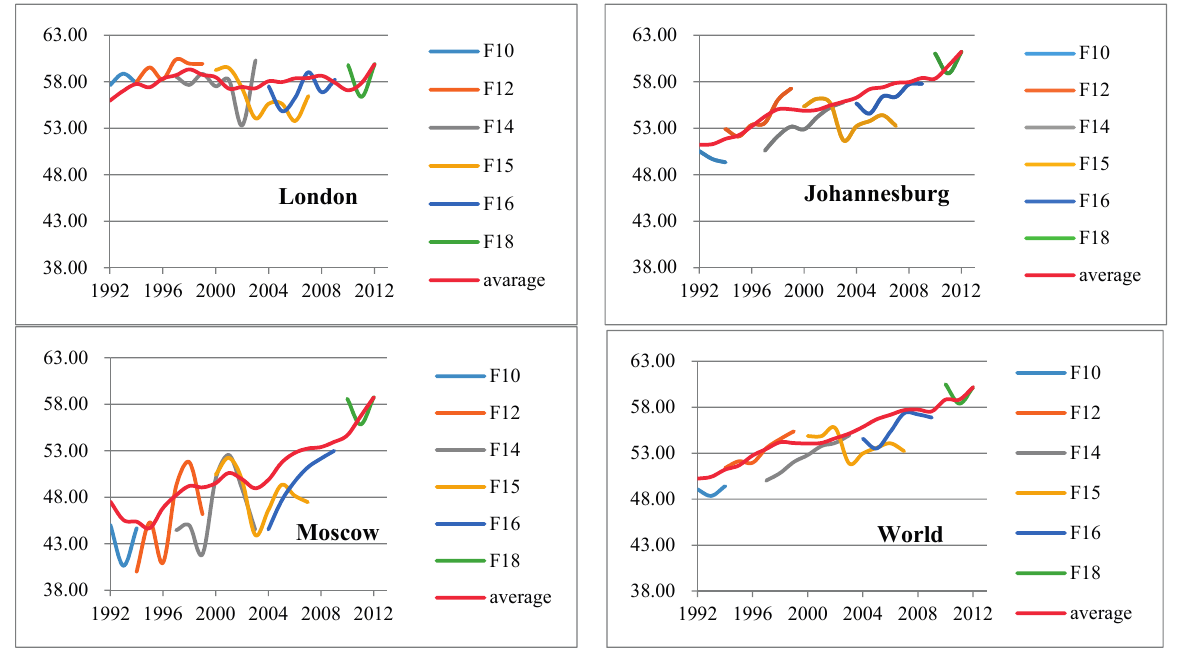
Figure 4. Examples of DN values of the urbanization area from different satellites after calibration during 1992–2012. F10–F18 express the original DN value, and the “average” line was the final value after